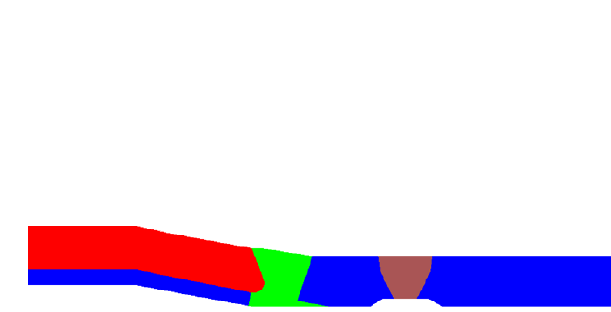
Figure 10: Residual stress distribution in Hot Leg. Figure 11: Cross section of hot leg and materials.